Question: State the chart type depicted above.
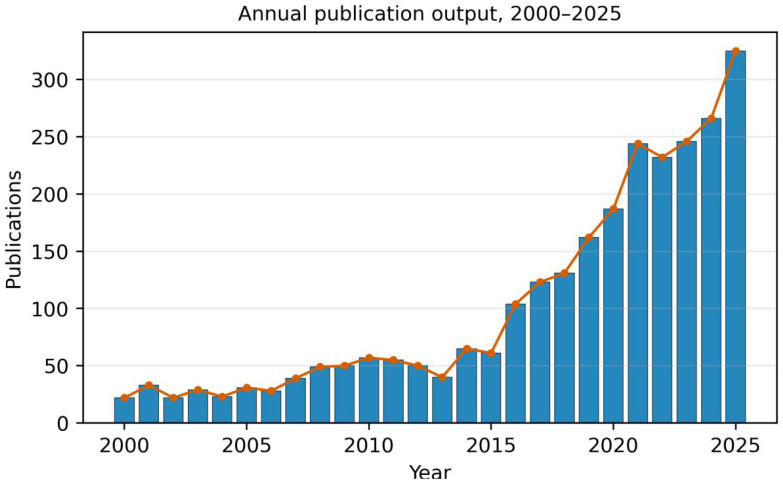
Answer: line